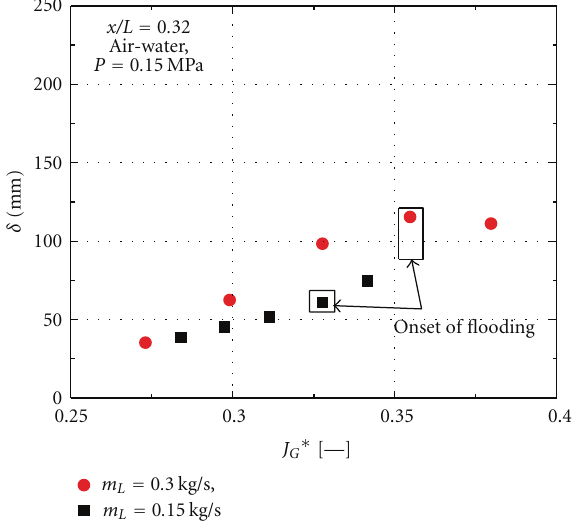
Figure 11: E ff ect of injected liquid mass flow rate on the water level.